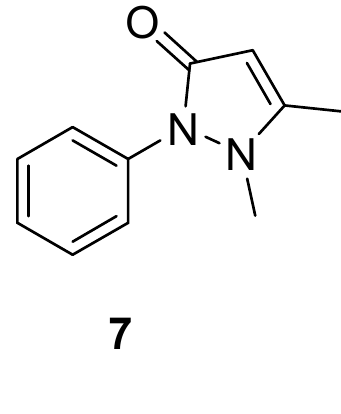
Figure 1. Acetylsalicylic acid ( 6 ) and phenazone ( 7 ).